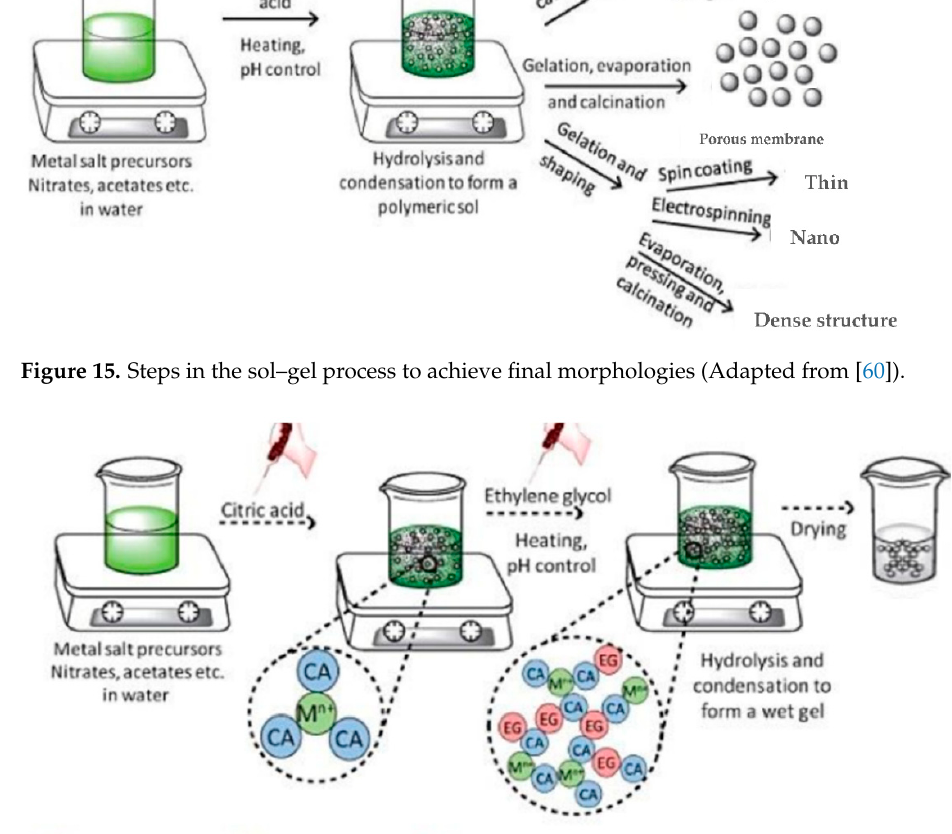
Figure 16. Schematic representation of Pechini’s method (Adapted from [60]).